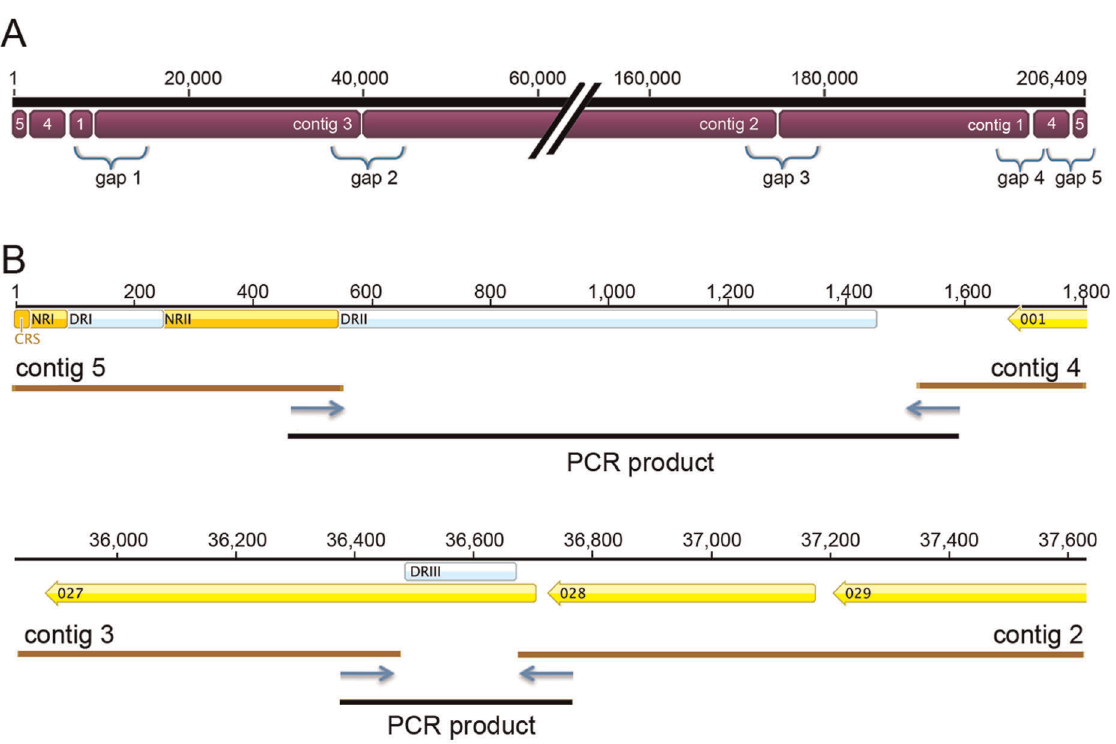
Figure 2. Assembly of contigs and gap closure. (A) Five contigs were assembled de novo using 159,077 sequence reads generated by pyrosequencing, providing an estimated coverage of 60X with 5 gaps. (B) The gaps were filled by PCR and Sanger sequencing. Blue arrows indicate positions of primers used for PCR. Gaps 2 and 5 contained direct repeats (DRs) necessitating synthesis and sequencing of additional internal PCR fragments. DRI contains a 69 bp sequence repeated 2.3X; DRII contained an 85 bp sequence repeated 10.4X; and DRIII contained a 25 bp sequence repeated 7.0X. The non-repetitive I (NRI) and NRII sequences flank DRI. ORFs are indicated by numbered yellow arrows.